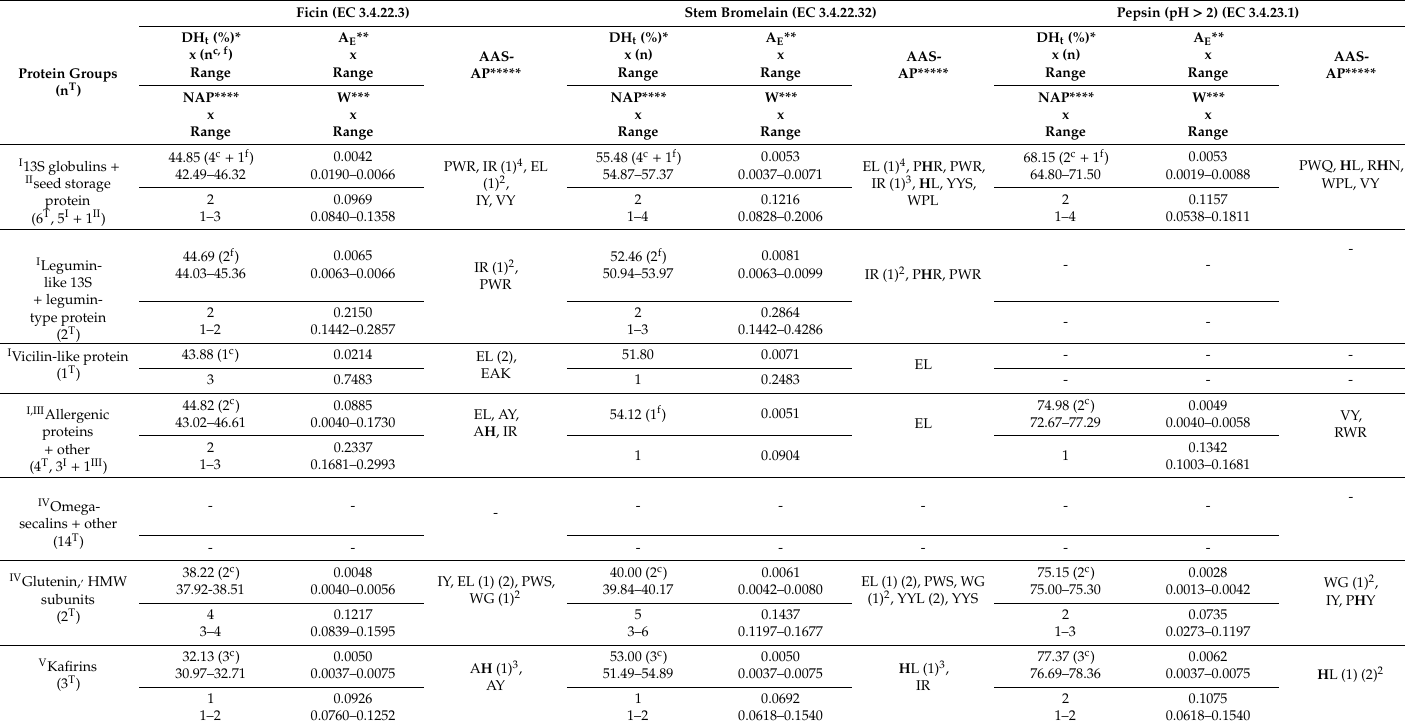
Table 10. The bioparameters characterising the in silico hydrolysis of buckwheat ( I Fagopyrum esculentum, II Fagopyrum gracilipes, III Fagopyrum tataricum ), rye ( IV Secale cereale ) and sorghum ( V Sorghum vulgare ) proteins and the molecular characterisation of the obtained antioxidant